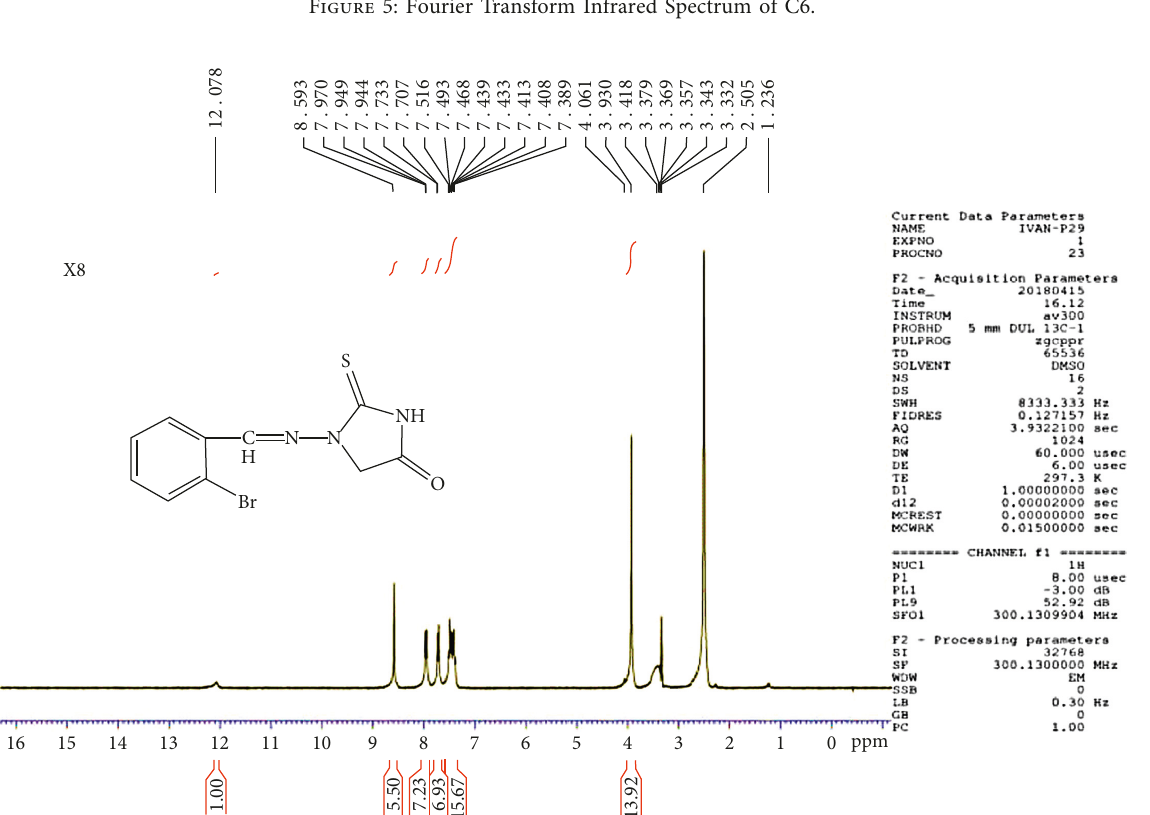
Figure 6: 1H-NMR spectrum of the C5